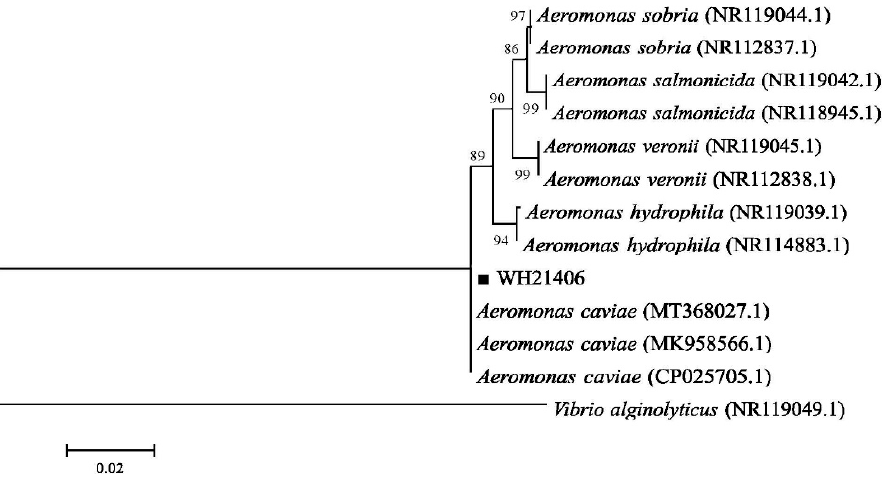
Figure 3. Phylogenetic tree for strain WH21406 on the basis of 16S rDNA sequences (the numbers represent bootstrap values).